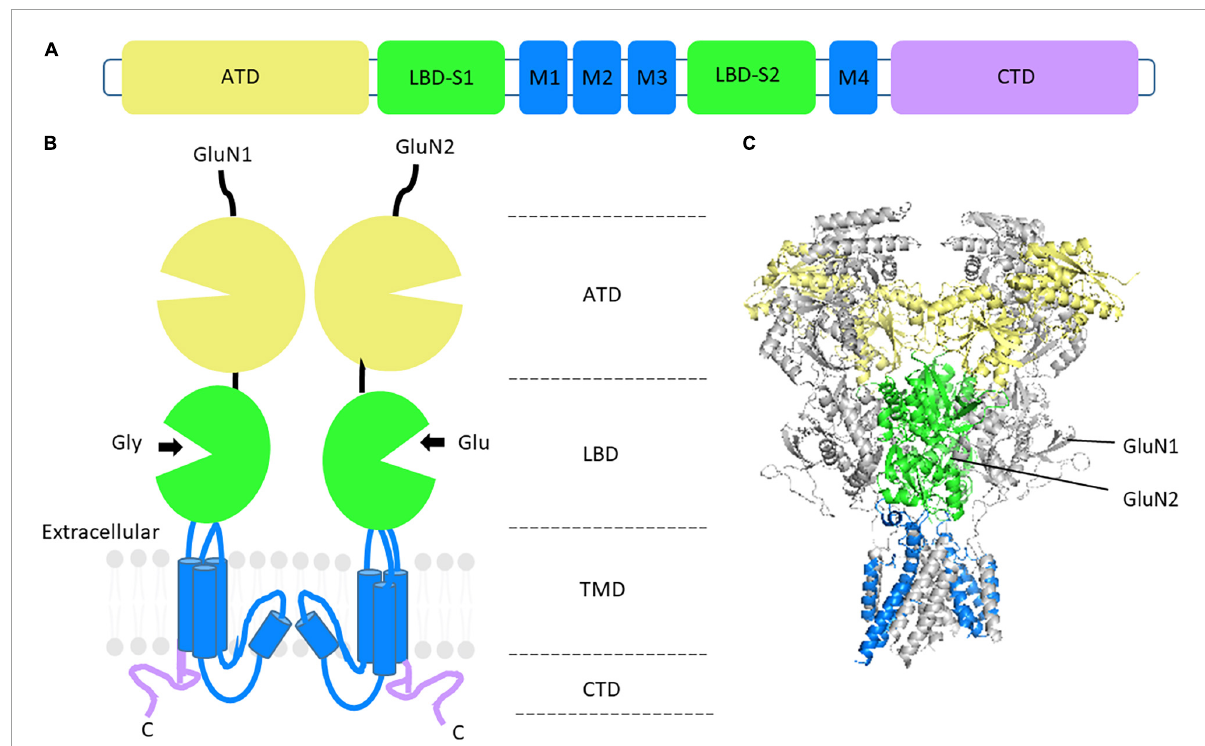
FIGURE1 NMDAR structure and GluN subunit domain architecture. (A) Linear representation of GluN subunit architecture. (B) Topology of a GluN1 and GluN2 subunit dimer. The extracellular domain consists of the amino-terminal domain (ATD) in yellow and the ligand-binding domain (LBD) in green. The transmembrane domains (TMD) and associated linker regions are shown in blue and the intracellular carboxy-terminal domain (CTD) is in purple. (C) Side view of the crystal structure of the rat GluN1_GluN2B heterotetrameric NMDAR, without CTD. GluN1 subunits are shown in gray. PDB: 4PE5 (Karakas and Furukawa,